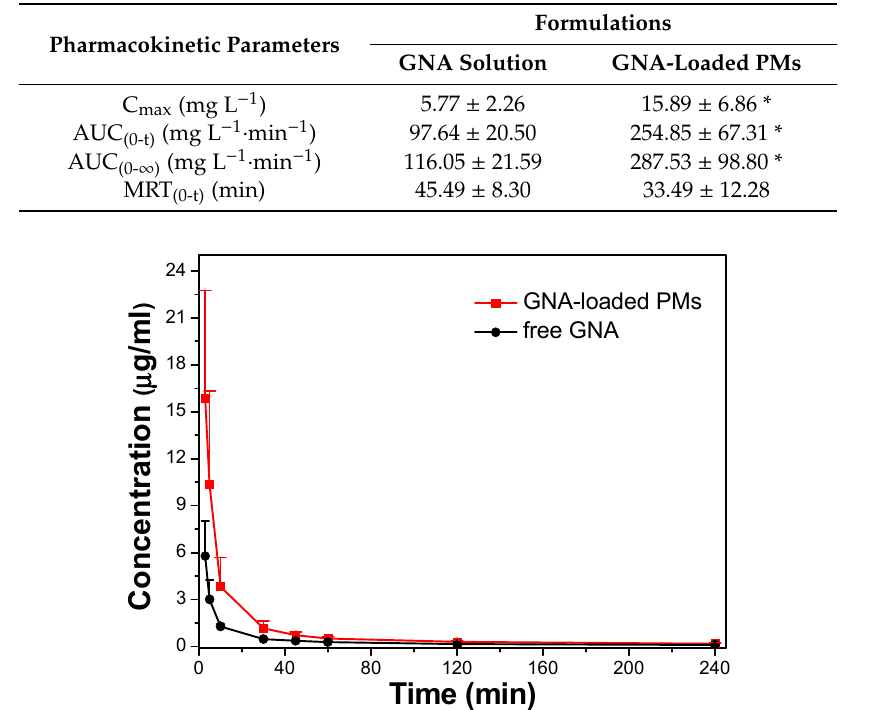
Figure 8. Mean plasma concentration-time profile of GNA in rats after intravenous administration GNA solution, GNA-loaded PMs at a single dose of 1.5 mg kg − 1 (Mean ± S.D., n = 6).